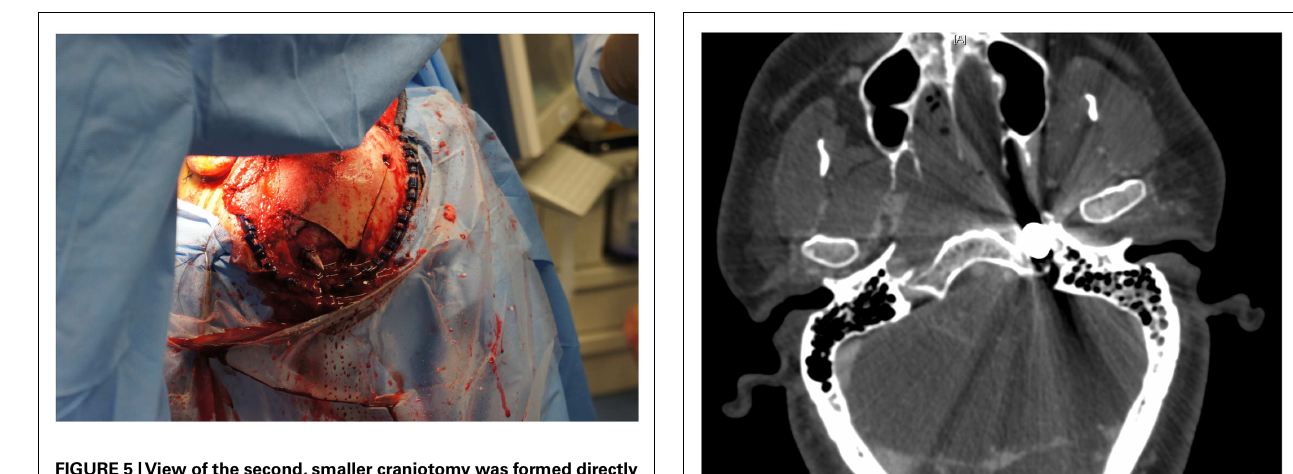
FIGURE 5 |View of the second, smaller craniotomy was formed directly surrounding the tip of the harpoon, allowing the bone to be removed by sliding it upward and posteriorly along the path of the projectile .